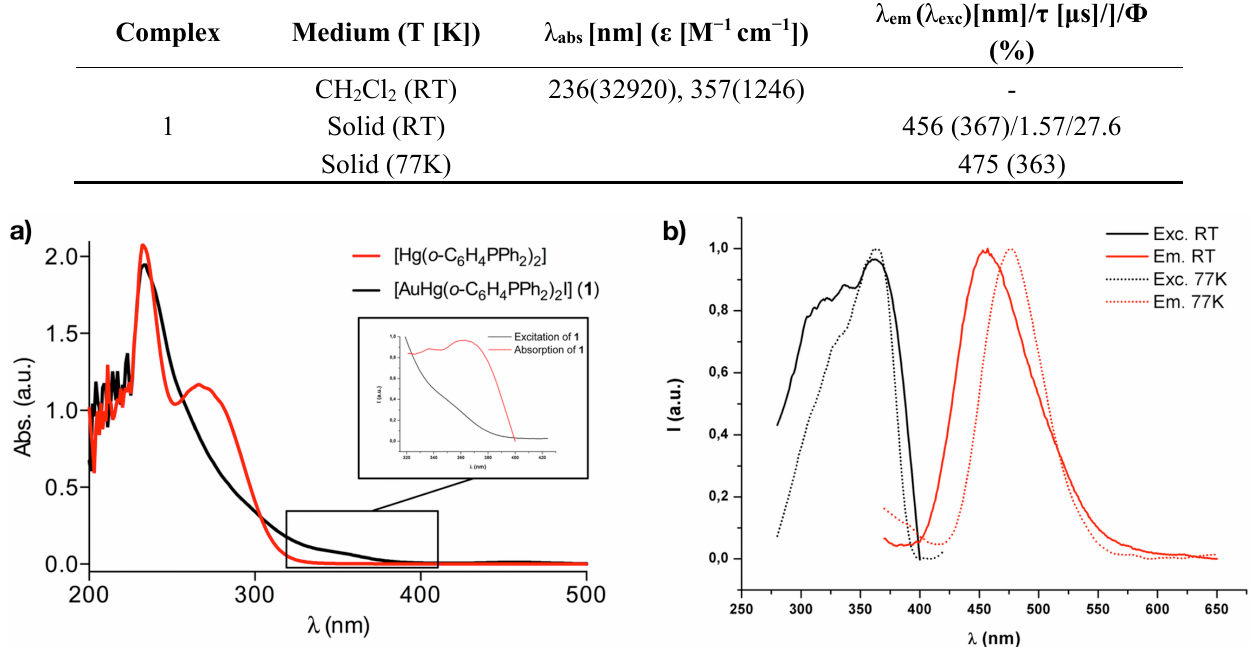
Figure 2. ( a ) UV-vis spectrum for complexes [Hg( o -C 6 H 4 PPh 2 ) 2 ] (red) and 1 (black) in dichloromethane solutions. ( b ) Normalized excitation (black) and emission (red) spectra in the solid state at RT (solid line) and emission at 77 K (dotted line) for complexes 1